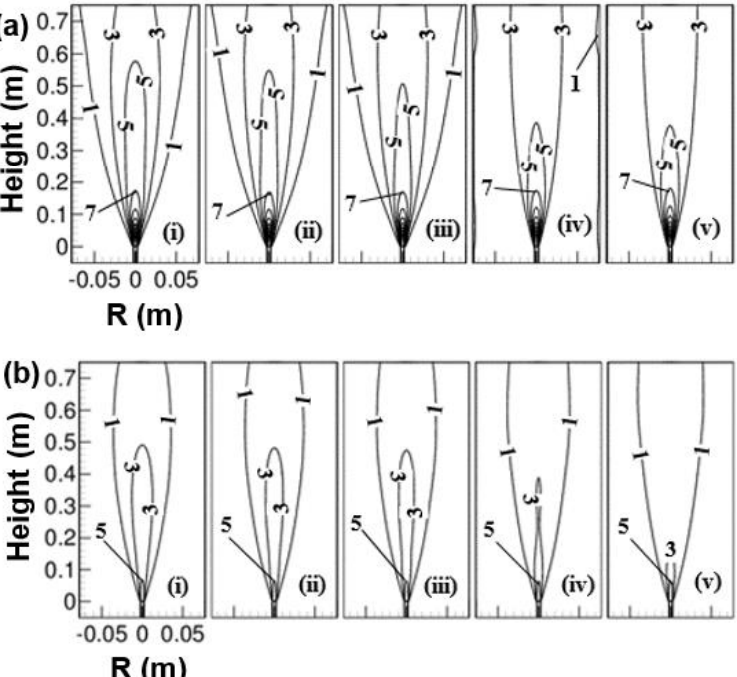
Figure 7. Isol-line of axial velocity contour as a function of air temperature; ( i ) 293 K, ( ii ) 373 K, ( iii ) 423 K, ( iv ) 573 K, and ( v ) 723 K and at two operating pressure of ( a ) 1 atm, and ( b ) 3 atm.